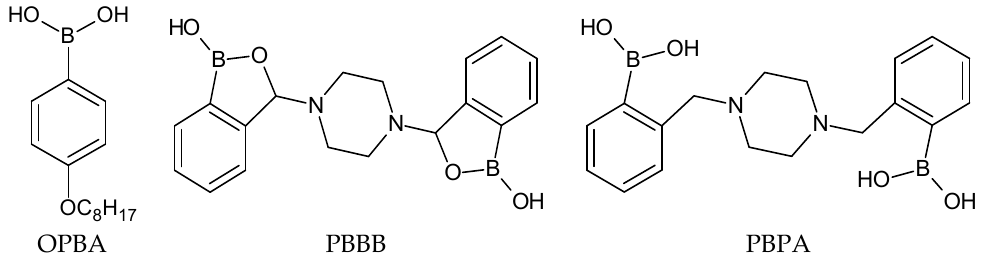
Figure 1. Structures of the studied organoboron receptors.